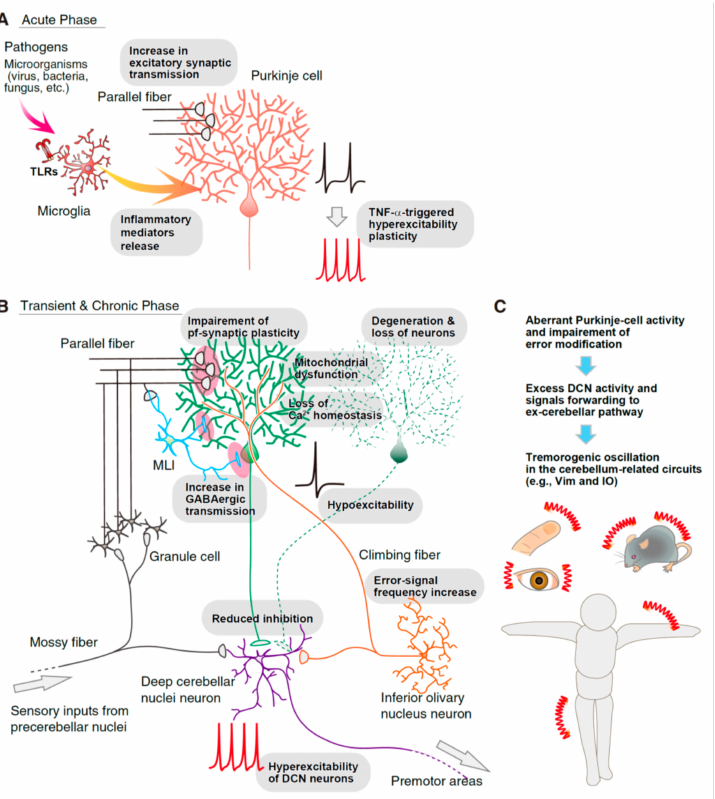
Figure 1. Transition of the cerebellar dysfunction in the infection model. ( A ) In response to